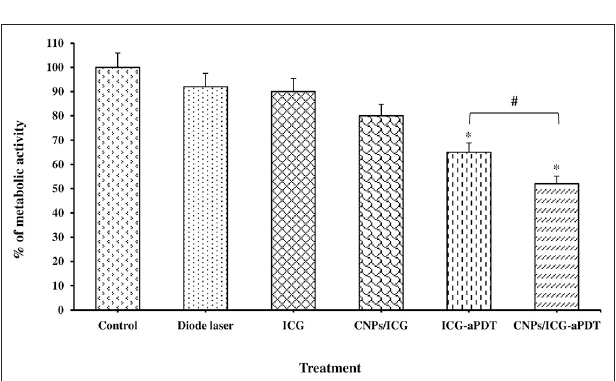
FIGURE 7 | Biofilm formation ability of Aggregatibacter actinomycetemcomitans after exposed with test groups. Results are represented as mean ± standard error of the mean. *Significant difference from control ( P < 0.05). # Significant difference between ICG-aPDT and